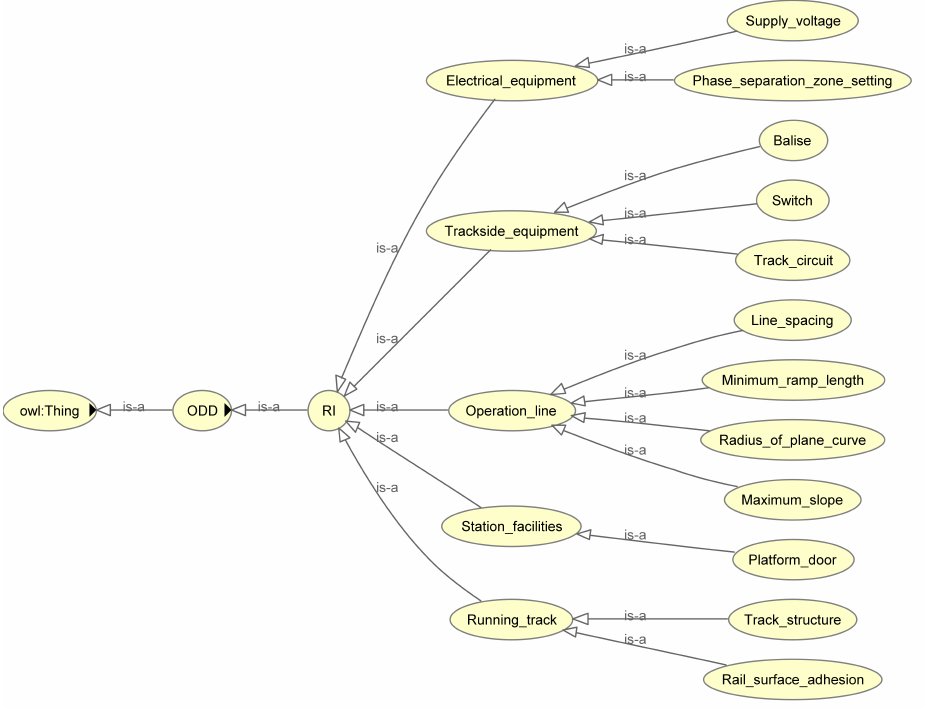
Figure 5. Structure diagram of Railway Infrastructure.